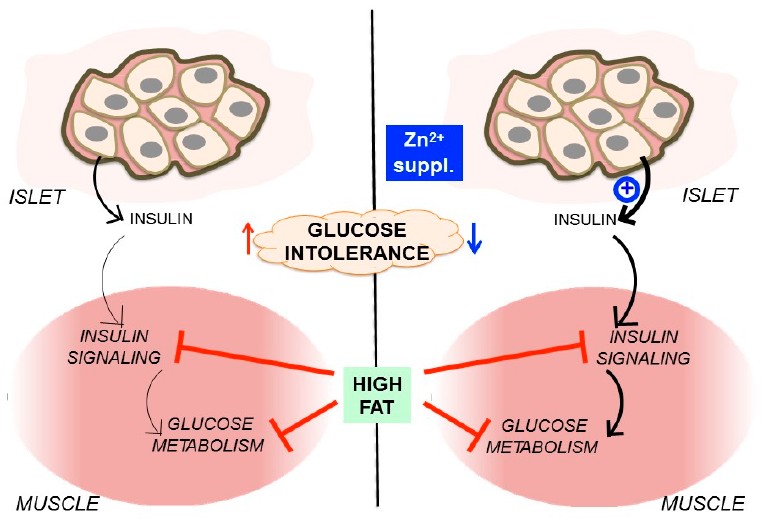
Figure 6. Improvement of glucose homeostasis by zinc supplementation in high fat-fed mice.